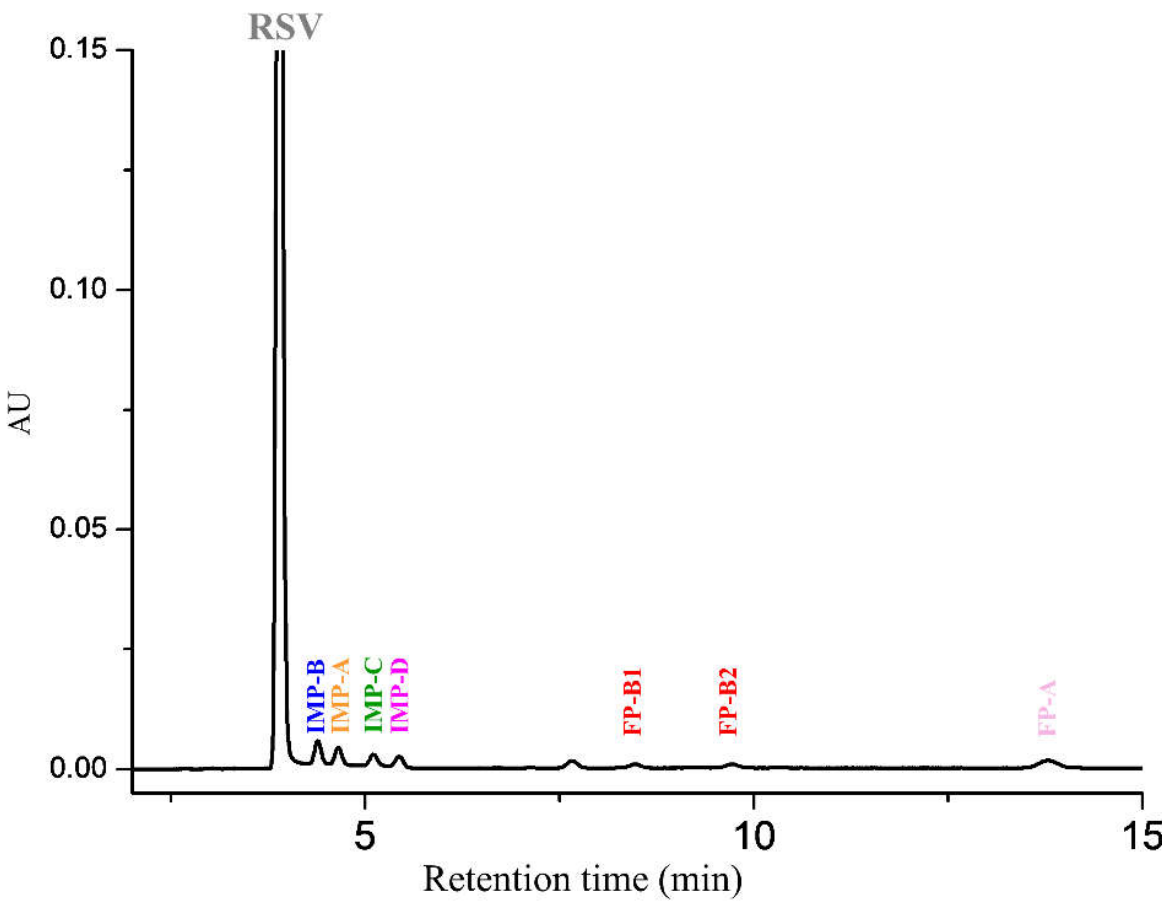
Figure 3. Optimized UHPLC chromatogram of RSV spiked with impurities.